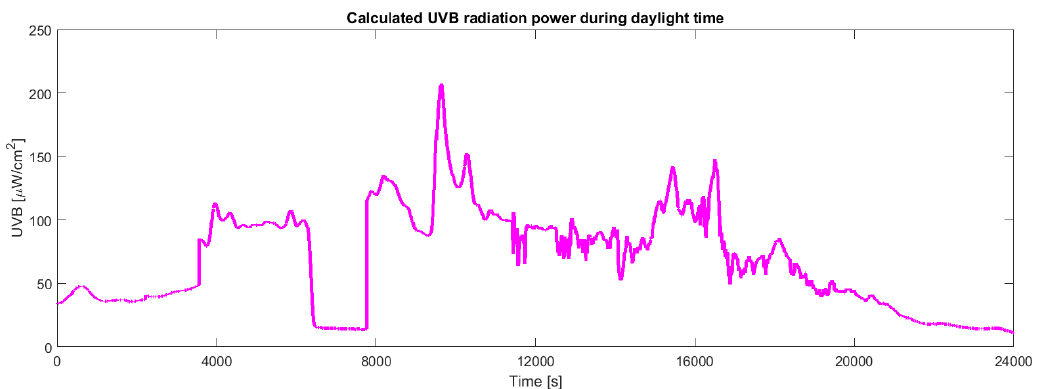
Figure 8. Behaviour of the UVB estimated from the VEML6070 sensor. Data have been continuously collected during a day.